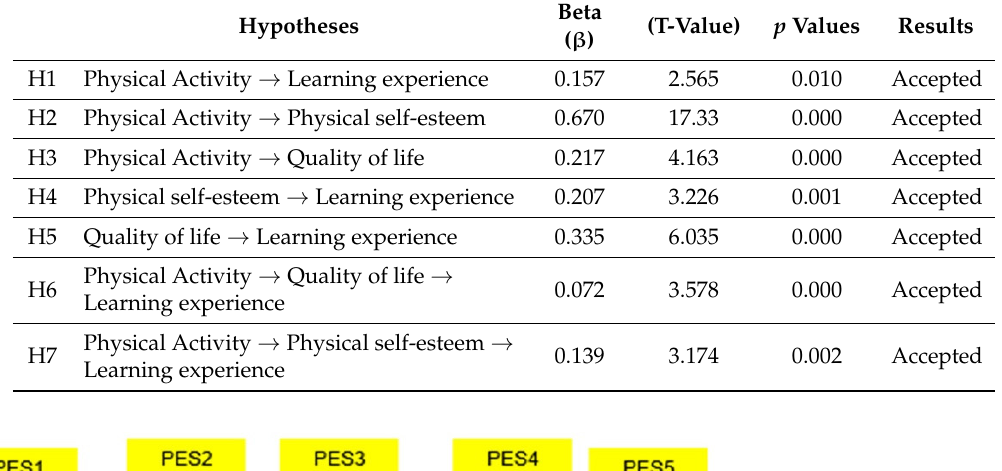
Table 6. Study Hypotheses Results.